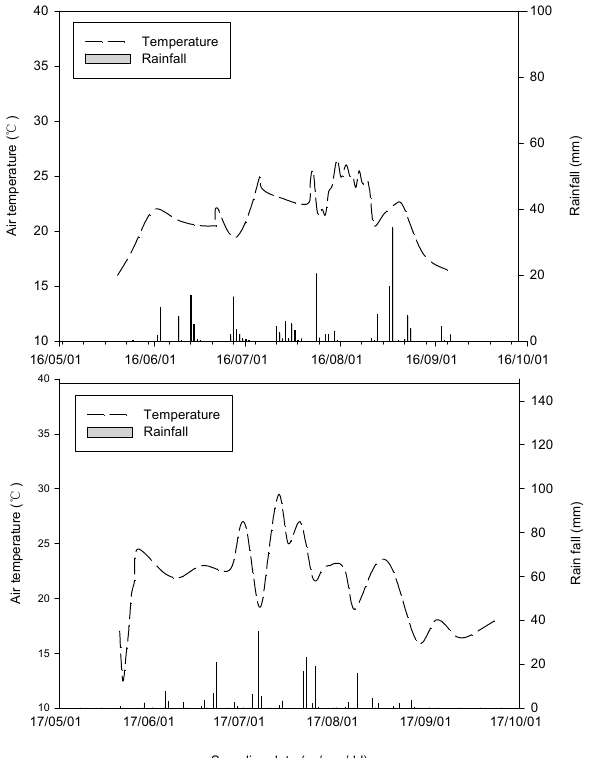
Figure 1. Temperature and precipitation measured at the potato experimental farm in 2016 and 2017. The rainfall values are the sum of daily rainfall. Air temperature is a daily average throughout the crop growing season.